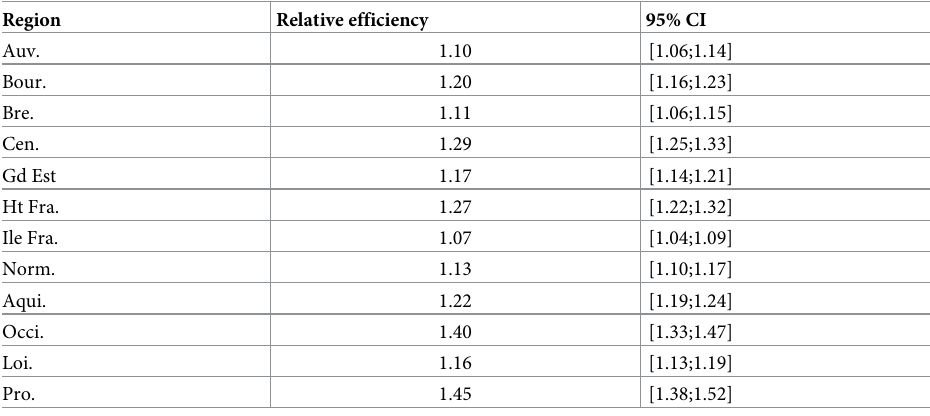
Table 11. Real-time estimate—relative efficiency being higher than one suggests increased predictive power of ARGONet compared to the autoregressive model AR(52). Region Relative efficiency 95% CI